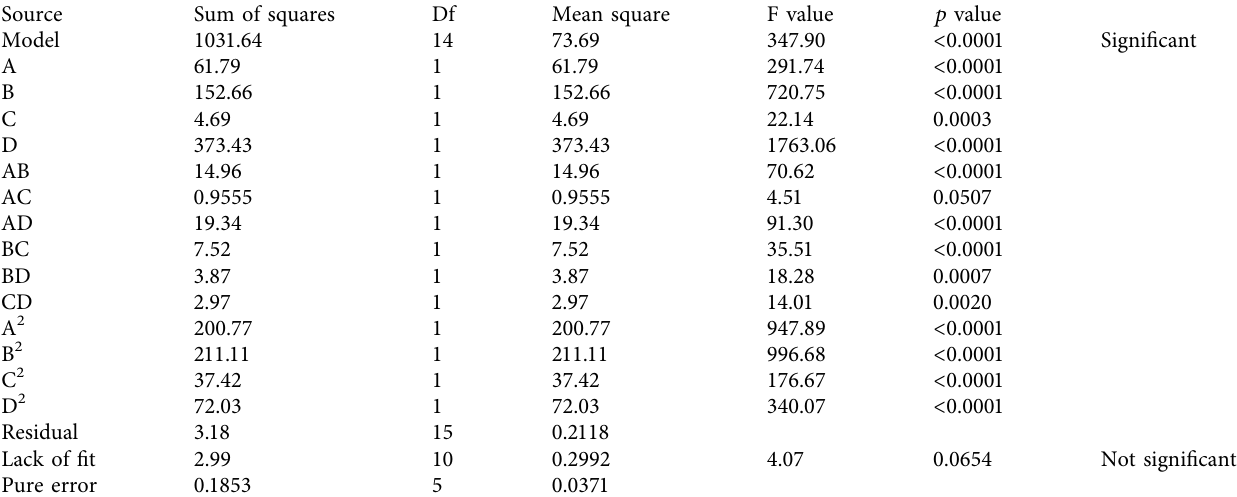
Table 5: Analysis of variance (ANOVA) for the quadratic